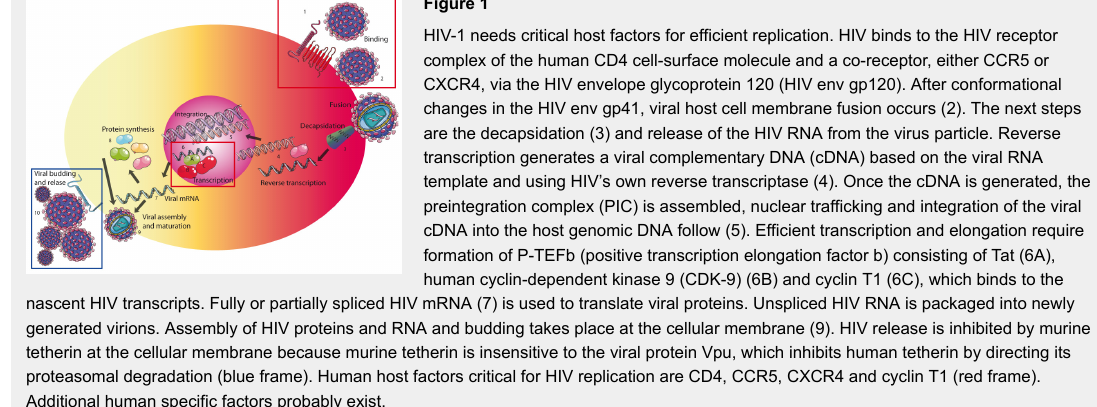
HIV-1 needs critical host factors for efficient replication. HIV binds to the HIV receptor complex of the human CD4 cell-surface molecule and a co-receptor, either CCR5 or CXCR4, via the HIV envelope glycoprotein 120 (HIV env gp120). After conformational changes in the HIV env gp41, viral host cell membrane fusion occurs (2). The next steps are the decapsidation (3) and release of the HIV RNA from the virus particle. Reverse transcription generates a viral complementary DNA (cDNA) based on the viral RNA template and using HIV’s own reverse transcriptase (4). Once the cDNA is generated, the preintegration complex (PIC) is assembled, nuclear trafficking and integration of the viral cDNA into the host genomic DNA follow (5). Efficient transcription and elongation require formation of P-TEFb (positive transcription elongation factor b) consisting of Tat (6A), human cyclin-dependent kinase 9 (CDK-9) (6B) and cyclin T1 (6C), which binds to the nascent HIV transcripts. Fully or partially spliced HIV mRNA (7) is used to translate viral proteins. Unspliced HIV RNA is packaged into newly generated virions. Assembly of HIV proteins and RNA and budding takes place at the cellular membrane (9). HIV release is inhibited by murine tetherin at the cellular membrane because murine tetherin is insensitive to the viral protein Vpu, which inhibits human tetherin by directing its proteasomal degradation (blue frame). Human host factors critical for HIV replication are CD4, CCR5, CXCR4 and cyclin T1 (red frame). Additional human specific factors probably